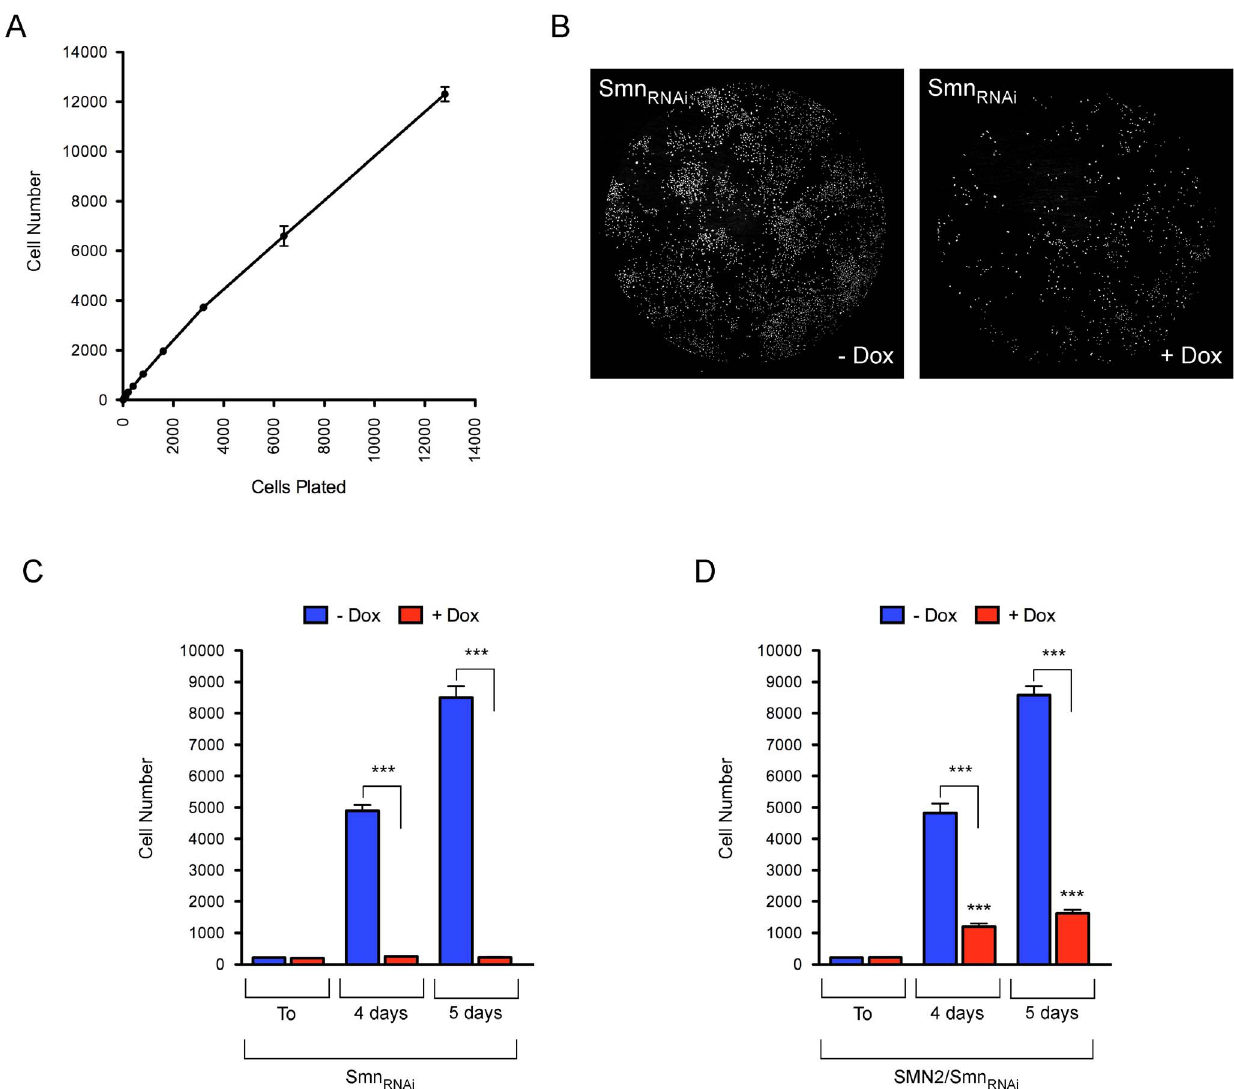
Figure 6. An SMN-dependent cell proliferation assay in 96-well format. (A) Automated determination of NIH3T3 cell number in 96-well format. Two-fold serial dilutions of NIH3T3-SMN2 low /SMN RNAi cells were plated in eight replicate wells of a 96-well plate. Following fixation and Hoechst staining 4 hours later, cell number was determined by imaging whole wells with an IN Cell Analyzer 2000. (B) Representative IN Cell Analyzer images of NIH3T3-Smn RNAi cells cultured with or without Dox in a 96-well format. (C–D) Analysis of SMN-dependent cell proliferation in NIH3T3- Smn RNAi (C) and NIH3T3-SMN2 low /Smn RNAi (D) cells using the 96-well format assay. NIH3T3 cells were cultured for 5 days with or without Dox, and then seeded in six replicate wells of a 96-well plate. Dox-treatment was continued throughout the experiment. Cell number was determined at 4 hours (T0), 4 days and 5 days post-plating. Data are represented as mean and SEM (n=6; ***=p , 0.001; two-way ANOVA). doi:10.1371/journal.pone.0071965.g006 not change the low level of Smn mRNA in either NIH3T3- deficient NIH3T3-SMN2 low /Smn RNAi cells compared to vehicle- SMN2 low /Smn RNAi or NIH3T3-Smn RNAi cells (Figure 8B–C), treated controls (Figure 8A). There was a maximum 2.5-fold indicating that it did not interfere with the doxycycline-dependent increase in cell number at 1 mM, while higher drug concentra- RNAi knockdown of endogenous mouse Smn. In contrast, VPA tions appeared toxic. Importantly, VPA treatment had no effect on treatment resulted in a , 1.5-fold increase in total SMN mRNA the proliferation of Smn-deficient NIH3T3-Smn RNAi cells lacking produced from the SMN2 gene in NIH3T3-SMN2 low /Smn RNAi the SMN2 gene (Figure 8A). The specificity of the effects for NIH3T3-SMN2 low /Smn RNAi cell lines containing the SMN2 gene cells compared to vehicle-treated cells (Figure 8C). A similar was consistent with the predicted mechanism of action for VPA in increase was also found for full-length SMN mRNA (data not increasing SMN2 gene expression. To determine whether this was shown). In agreement with the observed changes in mRNA levels, indeed the case, we compared SMN mRNA and protein levels in Western blot analysis showed that the low Smn protein levels were Smn-deficient NIH3T3-SMN2 low /Smn RNAi and NIH3T3- unaffected by VPA in Smn-deficient NIH3T3-Smn RNAi cells Smn RNAi cells treated with 1 mM VPA relative to vehicle-treated (Figure 8D), while VPA treatment increased SMN protein levels (1.7-fold, p , 0.01) in NIH3T3-SMN2 low /Smn RNAi cells compared controls. RT-qPCR experiments showed that VPA treatment did